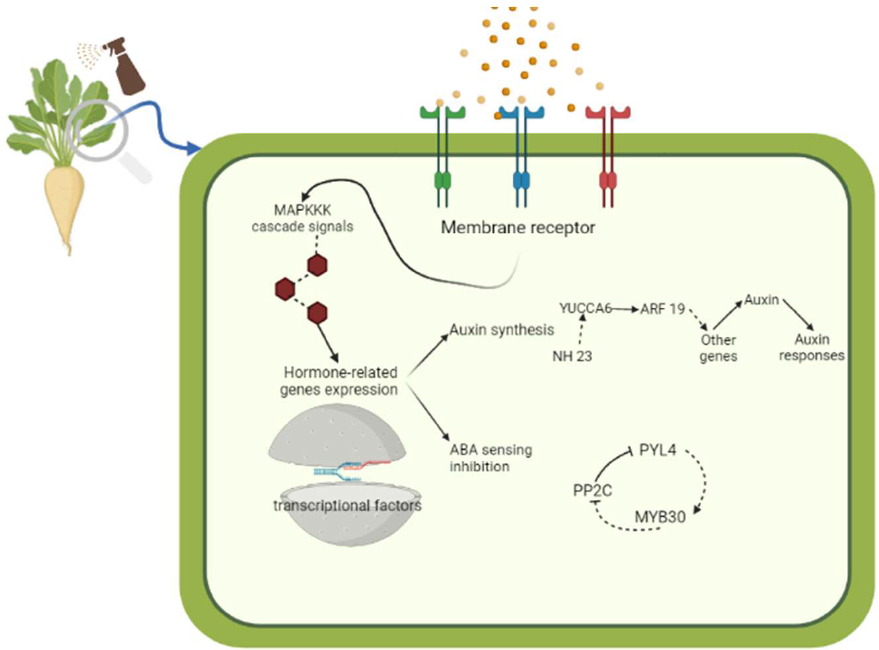
Figure 5. Putative representation of the BSE mode of action. The BSE foliar treatment is perceived by a complex sensing mechanism made of different membrane receptors that can trigger a classic MAPKKK cascade signaling, resulting in a regulatory response of different pathways. In this study, it is shown that the different dosages of BSE treatment can alter the expression level of the key genes involved in auxin- and ABA-related gene expression with consequent effects on the root development and sugar yield in the sugar beet.